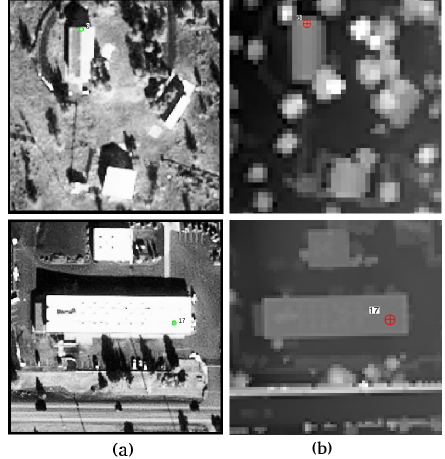
Figure 3: Oregon; sample GCPs in (a) satellite, (b) LiDAR